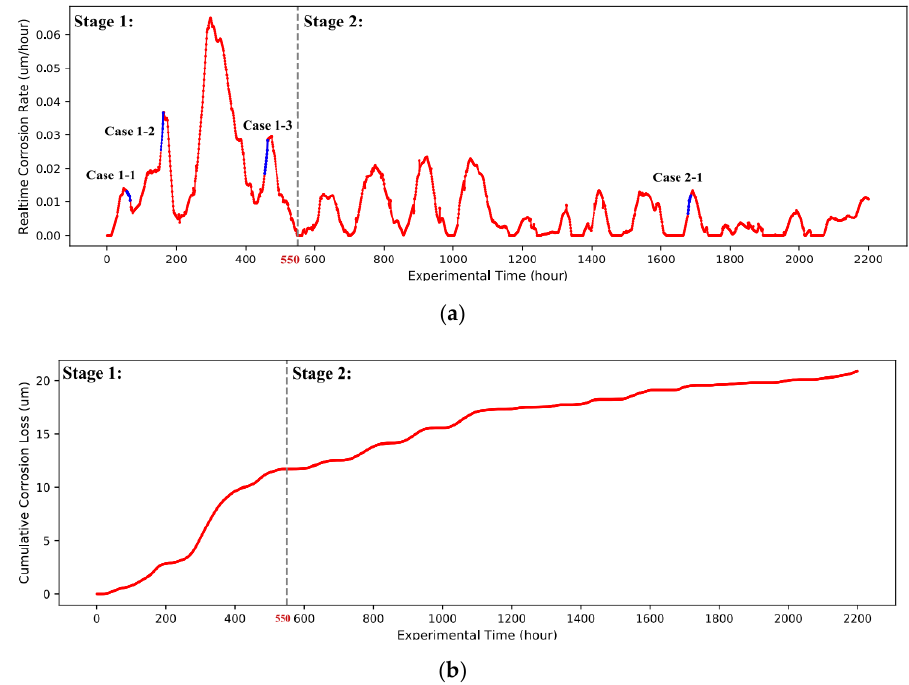
Figure 3. Variations of corrosion data with exposure time. ( a ) Corrosion rate ( μ m/h); ( b ) cumulative corrosion loss ( μ m).